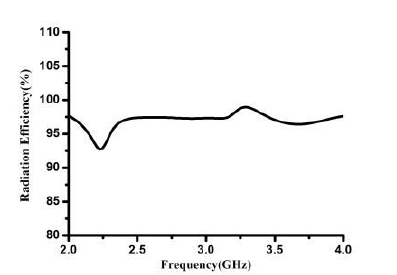
Figure 8: Radiation efficiency of the proposed antenna